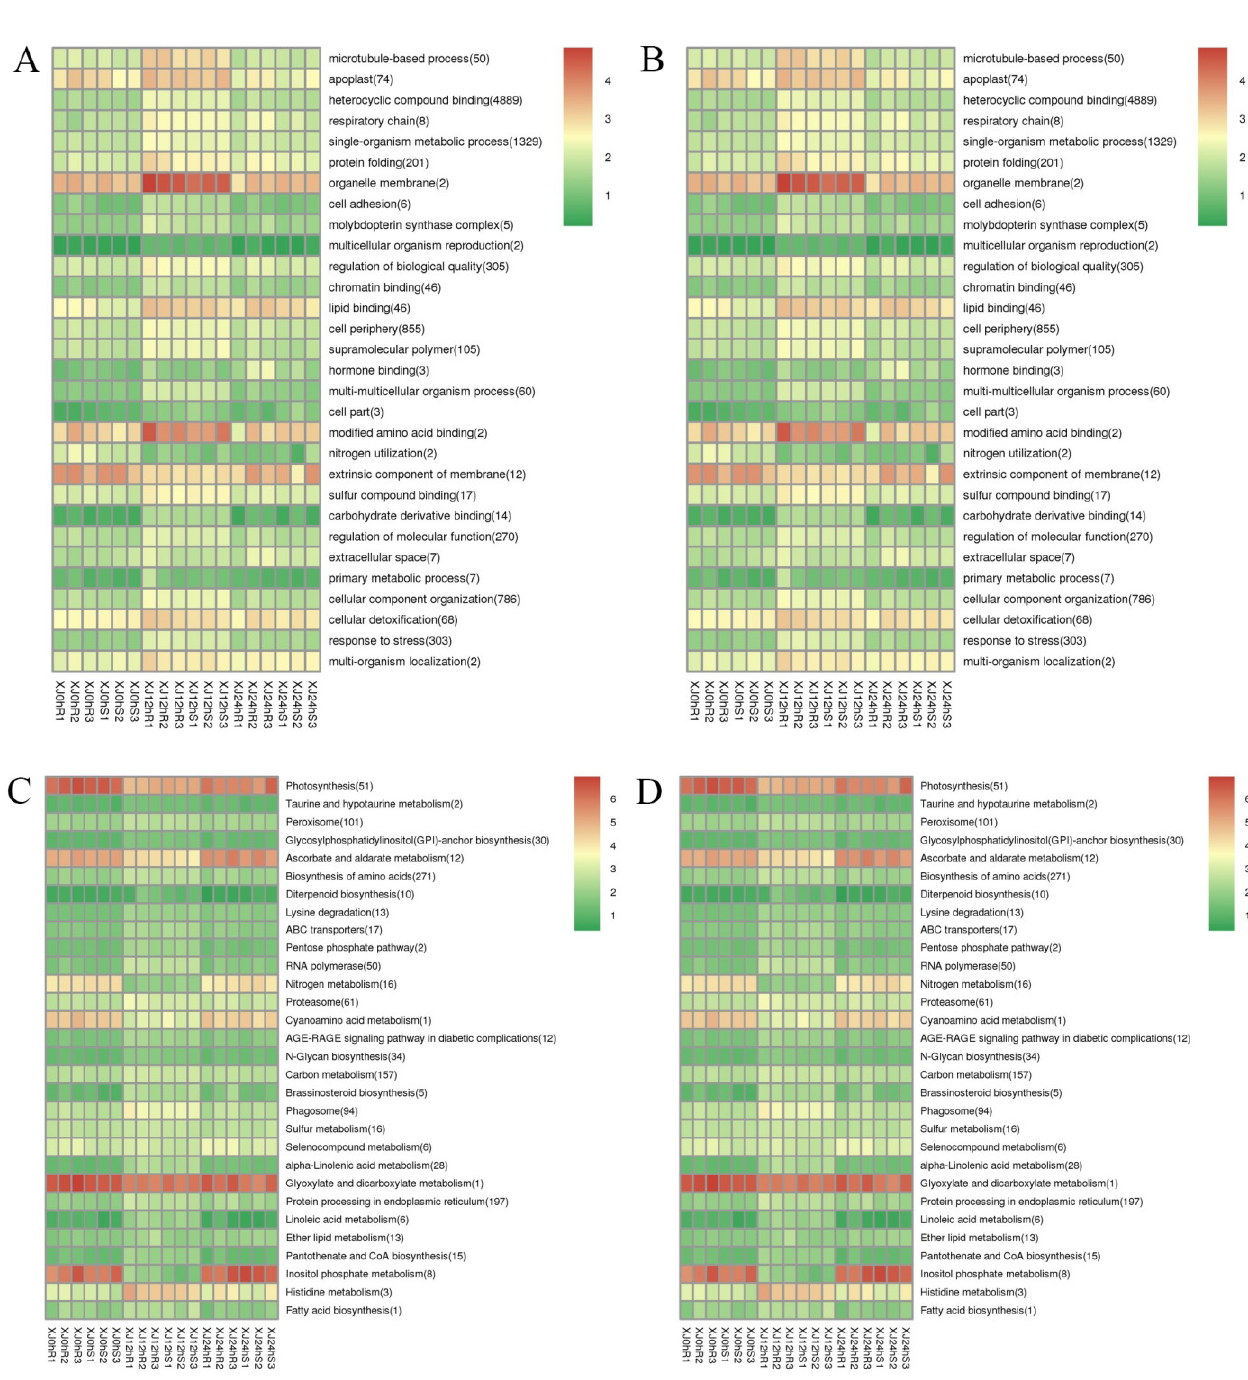
Figure 8. ( A ) Clustering graph of the GO enrichment of differentially expressed lncRNA cis-target genes. ( B ) Clustering graph of the GO enrichment of differentially expressed lncRNA trans-target genes. ( C ) Cluster map of the KEGG enrichment of differentially expressed lncRNA cis-target genes ( D ) Cluster map of the KEGG enrichment of differentially expressed lncRNA trans-target genes. Note: Red indicates metabolic pathways with high expression, and green indicates metabolic pathways with relatively low expression. The parentheses after the label of each metabolic pathway include the number of genes with significant differences in the metabolic pathway.